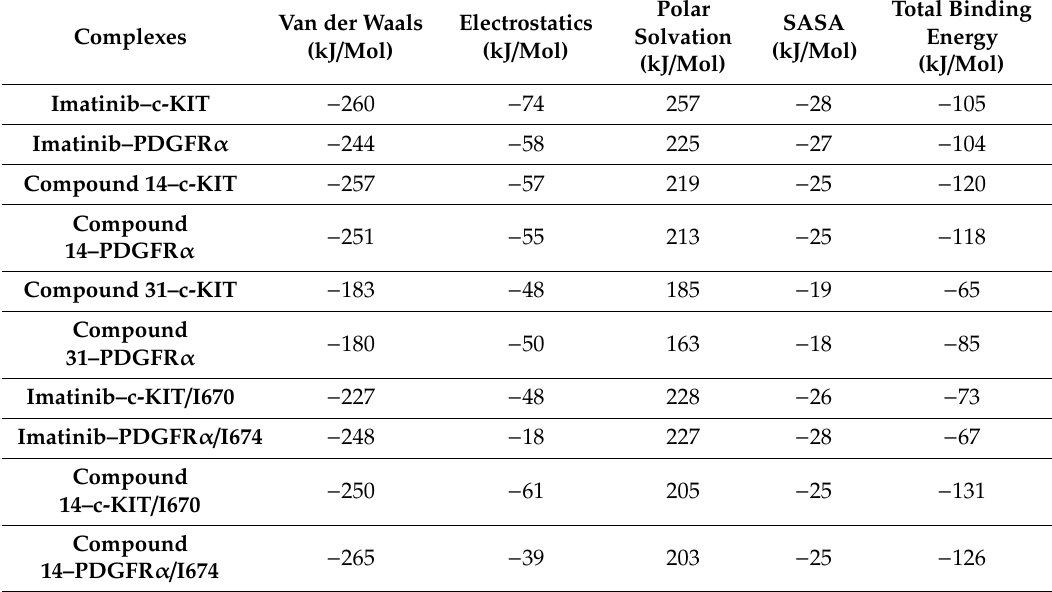
Table 2. The energy contribution of the various energetic terms (Van der Waals energy, electrostatic energy, polar solvation energy, and non-polar solvation energy / solvent-accessible surface area (SASA)) to the total binding energy during the binding of imatinib and compound 14 with c-KIT and PDGFR α .